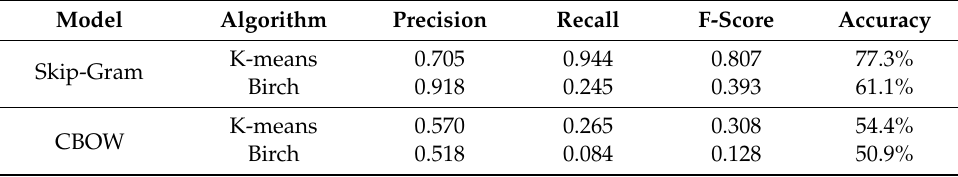
Table 14. Summary for clustering algorithms with entity embedding models on the test